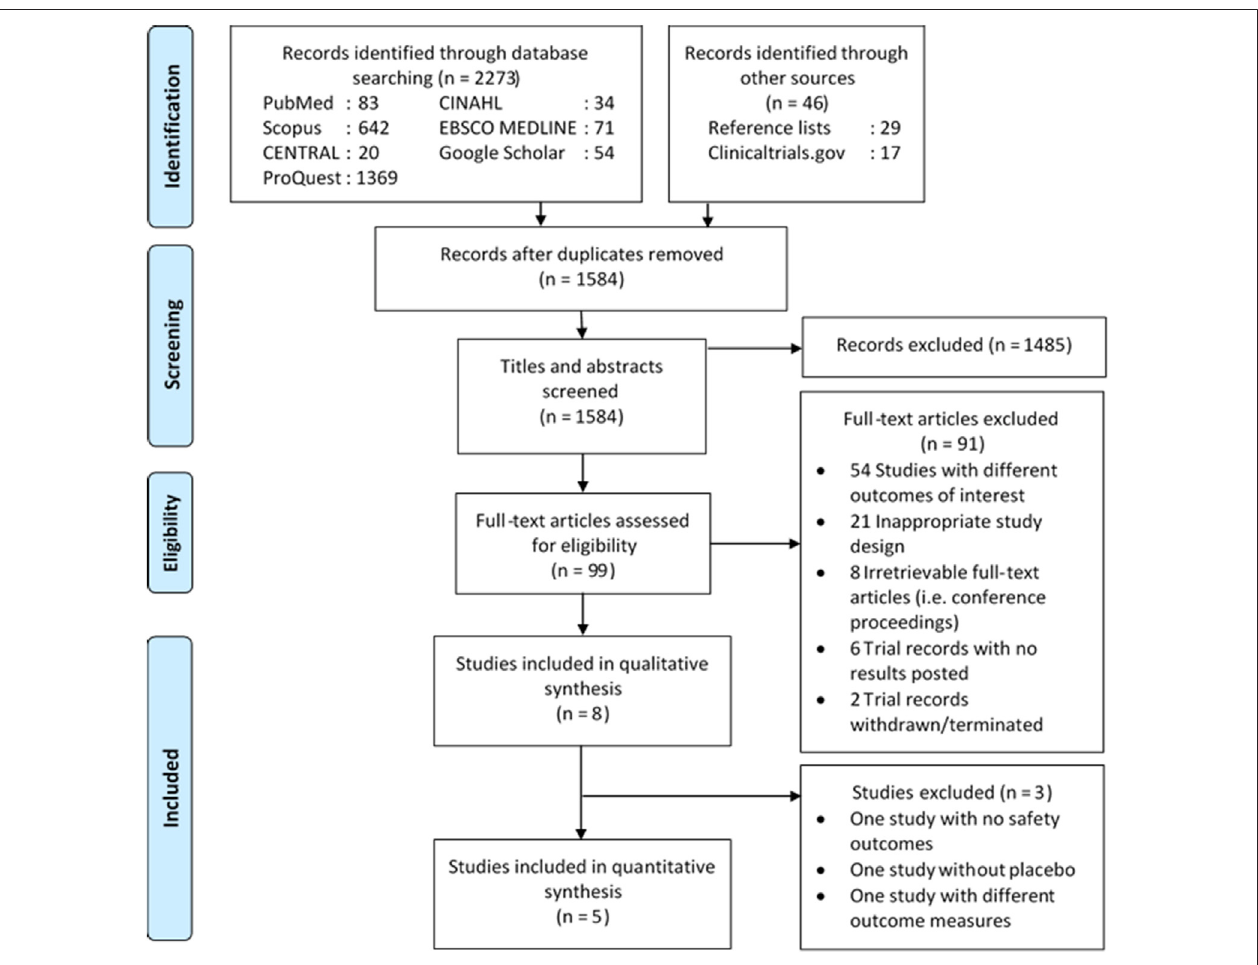
FIGURE 1 | Diagram fl ow illustrating literature search process. CENTRAL, Cochrane Central Register of Controlled Trials; CINAHL, Cumulative Index to Nursing and Allied Health Literature.